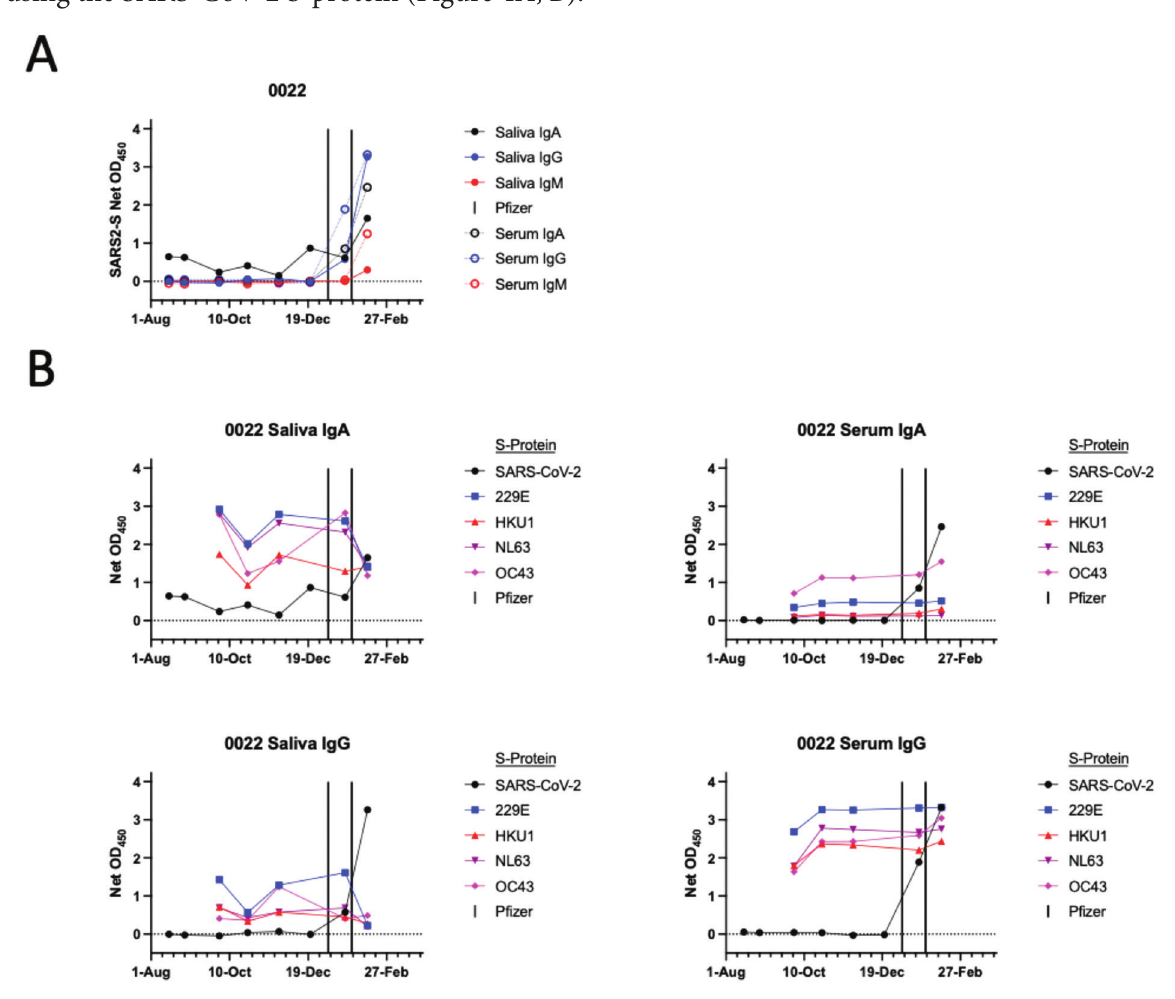
Figure 4. Antibody response to the common cold CoV S-proteins in saliva and sera from participant 0022. A) The format of this panel is the same as Figure 1 and shows data derived using the SARS-CoV-2 S-protein. B) The panels show saliva or serum IgA or IgG antibody responses to S-proteins from the endemic CoVs 229E, HKU1, NL63, and OC43, in comparison to SARS-CoV-2, as